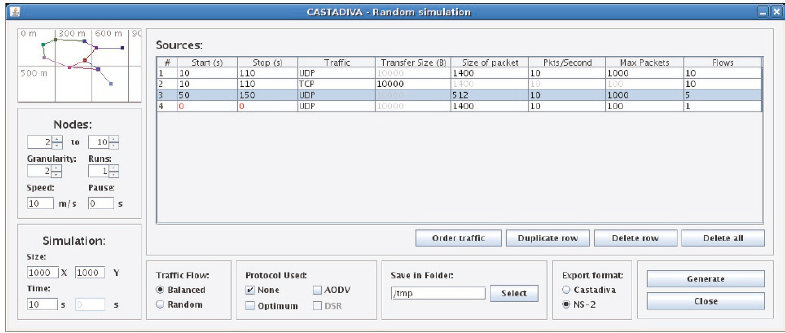
Figure 9: Random test